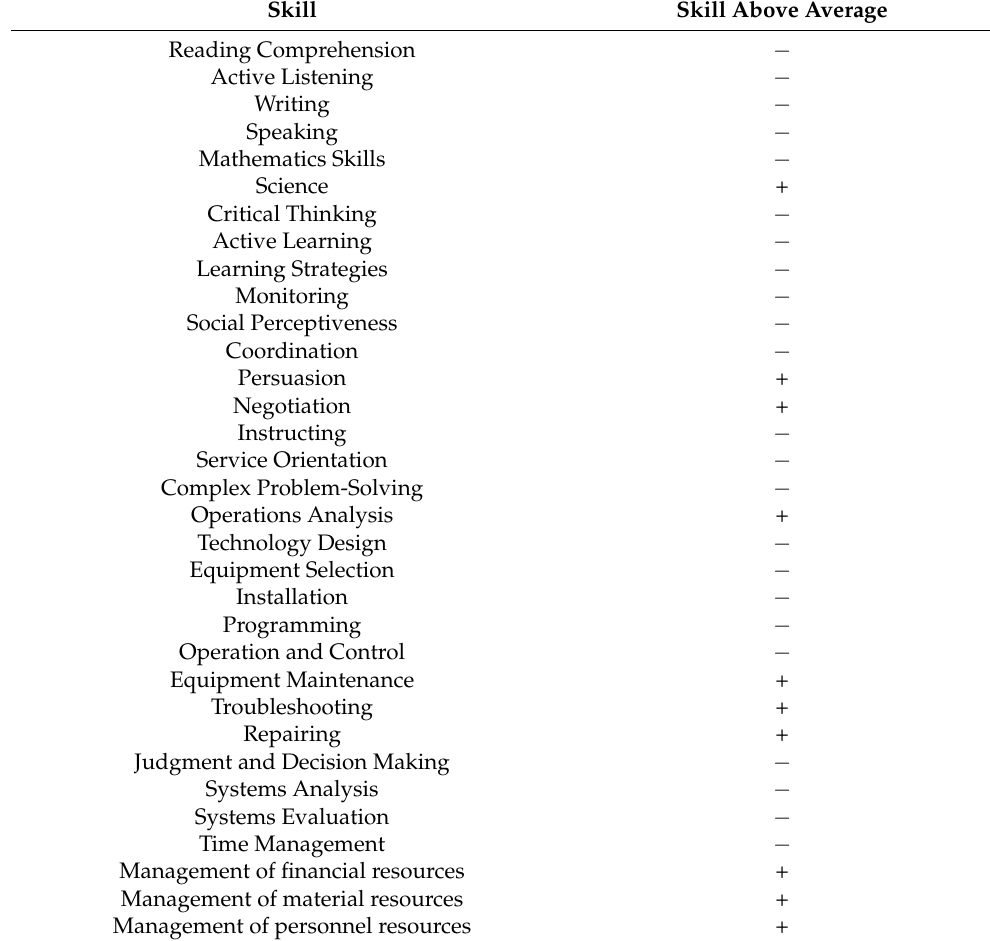
Table 7. Soft skills to improve in Spain. Source: own elaboration based on data from OECD data [57]. Skill Skill Above